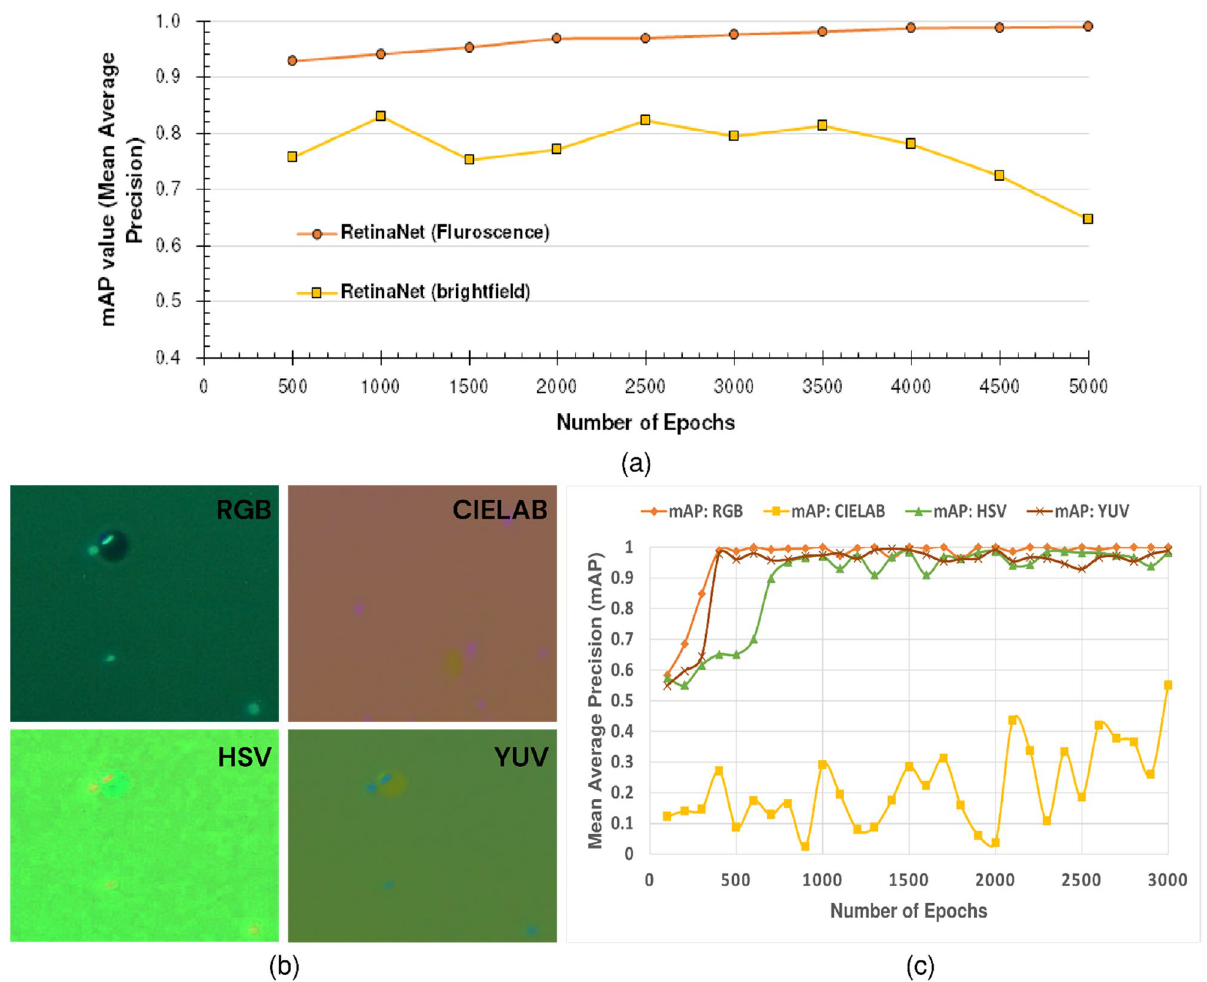
Figure 10. Training mAP of RetinaNet in brightfield and fluorescent image datasets. Brightfield images didn’t contain any color information whereas fluorescent images had color information. ( a ) The training was done for 5000 epochs initially for both the brightfield images and fluorescent images. ( b ) The training was re-done on images of different color spaces. (Top to bottom) The different color spaces include RGB, CIELAB, HSV, and YUV, respectively. ( c ) The same model was re-trained on the above-mentioned datasets and portrays the importance of color as a feature for detecting artifacts in our microscopic